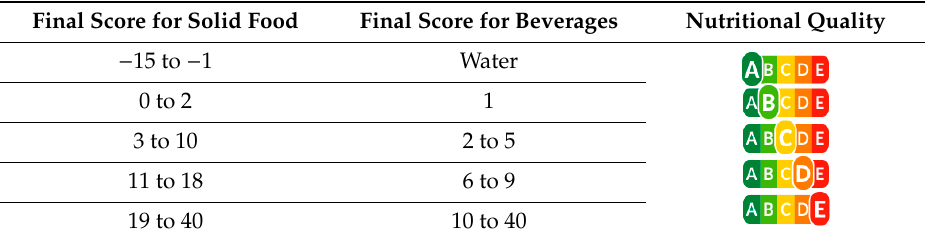
Table 2. Nutritional quality class according final score [51].